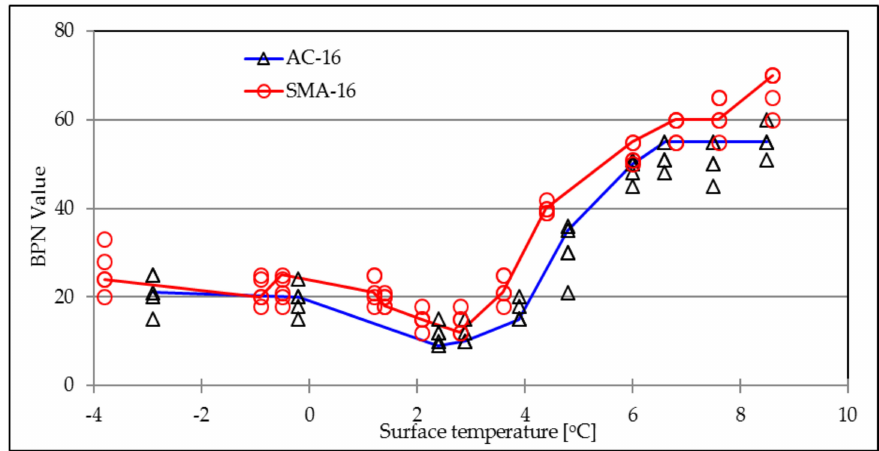
Figure 4. BPN values of traditional surface layers during ice-melting process.